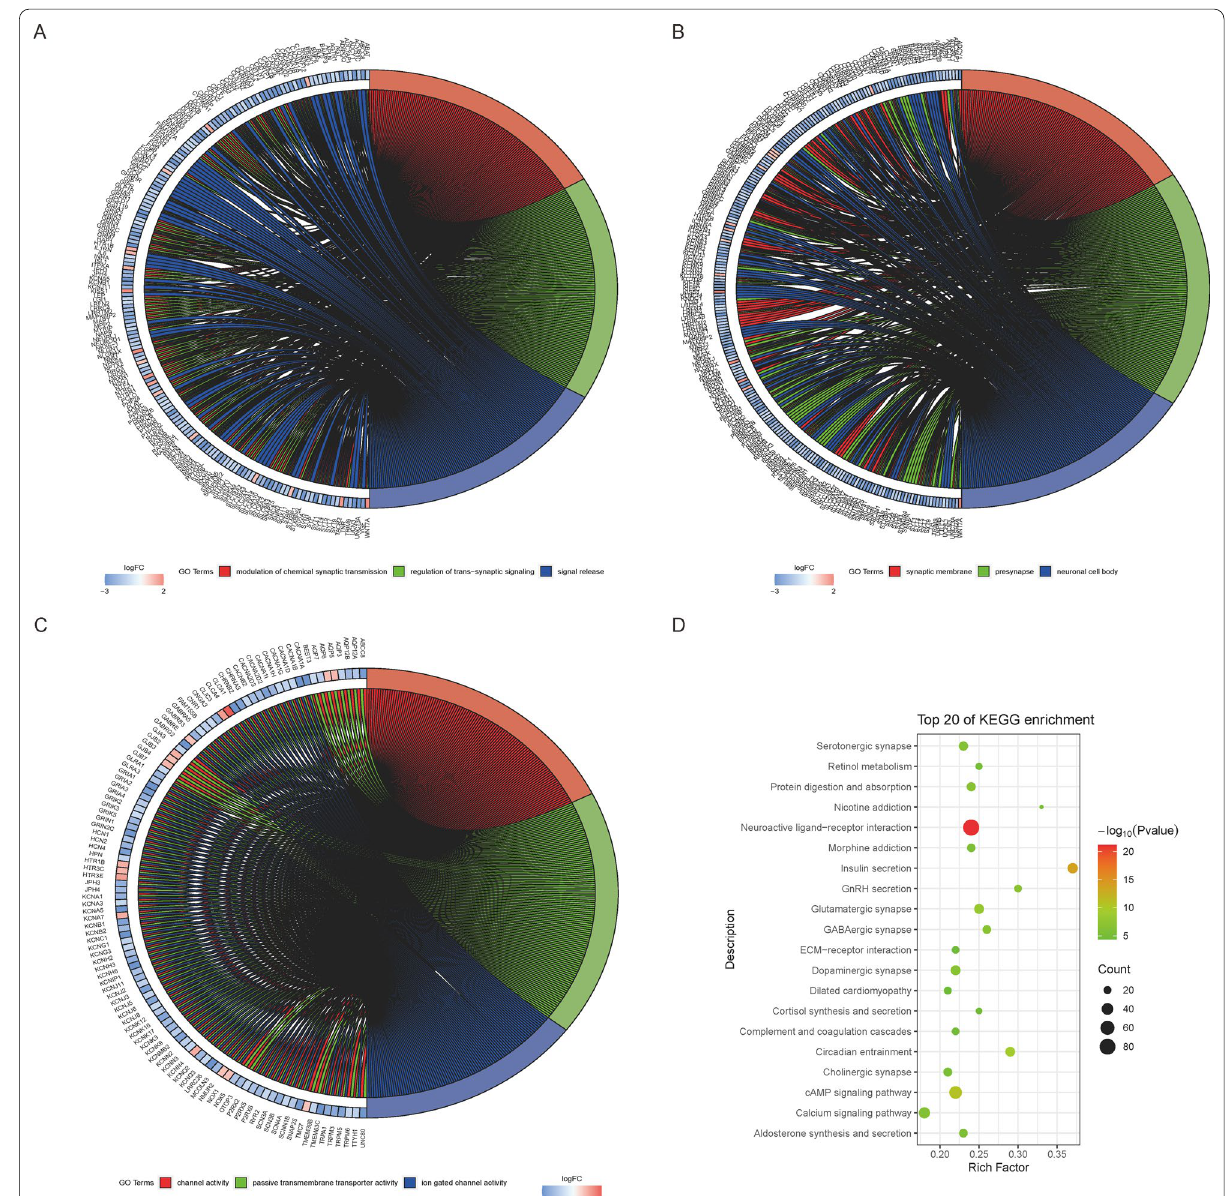
Fig. 3 A – C The results of functional enrichment analysis, which included three types of GO analysis: the enrichment pathways with the highest P-value are on the left, and the corresponding genes of the enrichment pathways are on the right. Log FC represents the differential expression multiple of these genes. D KEGG analysis: The higher intensity of red represents higher significance. The larger the dot, the more genes enriched in that